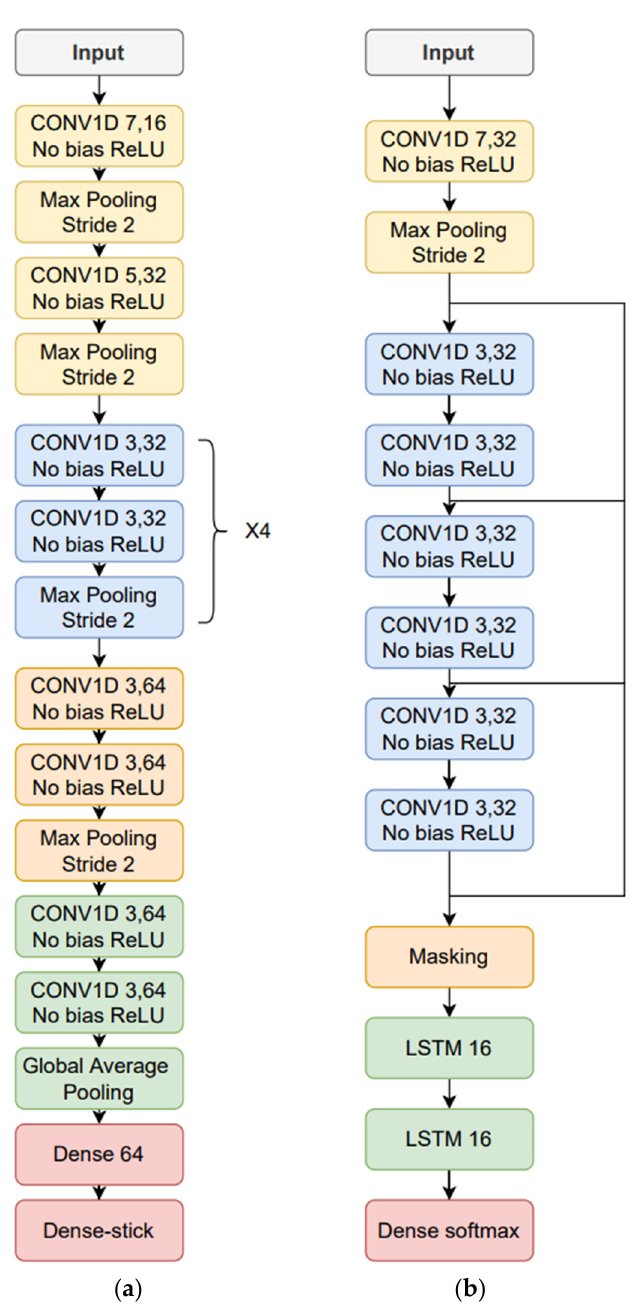
Figure 3. Neural network architectures for: ( a ) /ae-ae/ and /sa-sa/ phonetization; and, ( b ) one-to- thirty counting vocalization.